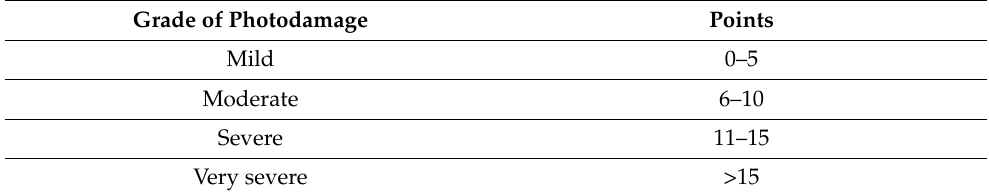
Table 2. Photodamage Severity index.